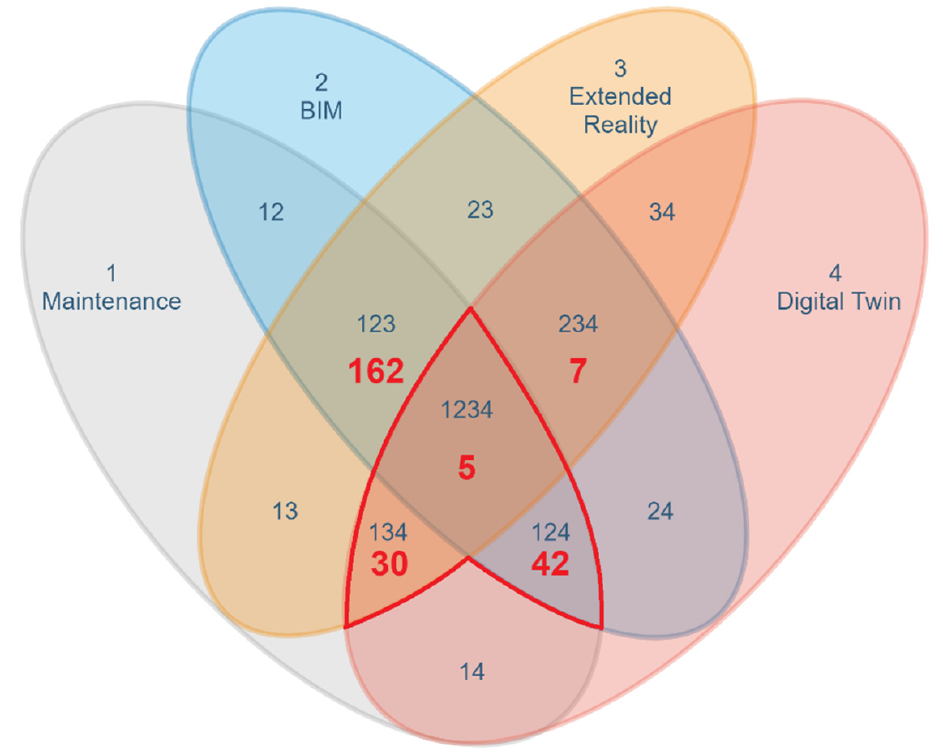
Figure 2. Venn diagram of the terms combinations used for our research. The red outline delimits the combinations selected for our research. The red numbers represent the number of papers found for the combination of three and four terms.